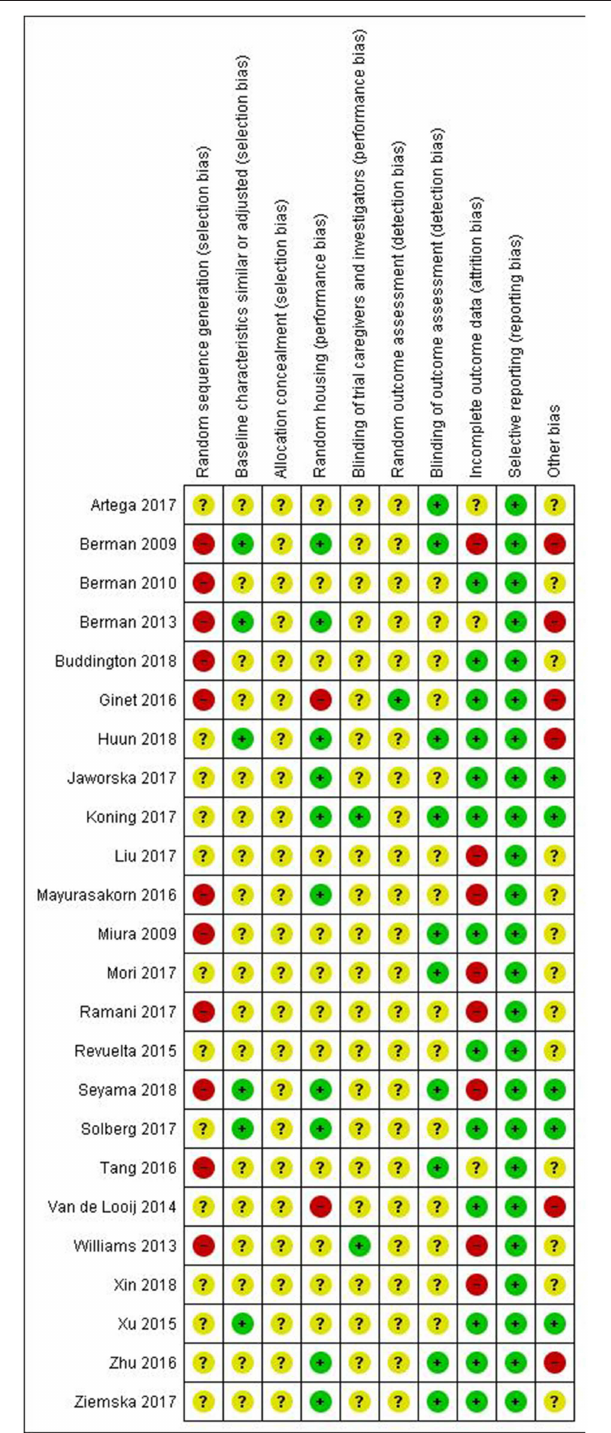
FIGURE 3 | Risk of bias of individual pre-clinical studies.